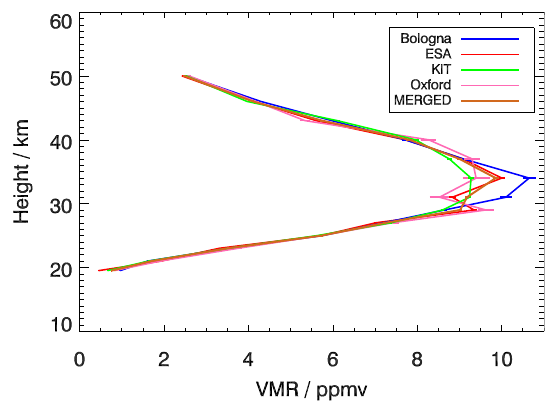
Figure 3. Parent MIPAS profiles and the resulting merged MI- PAS profile on geolocation 33441_20080723T072843Z (0.2 ◦ S, 40.5 ◦ E). The profile from the Bologna processor is the blue line; from the ESA processor, red; from the KIT processor, green; and from the Oxford processor, pink. The merged profile is the brown